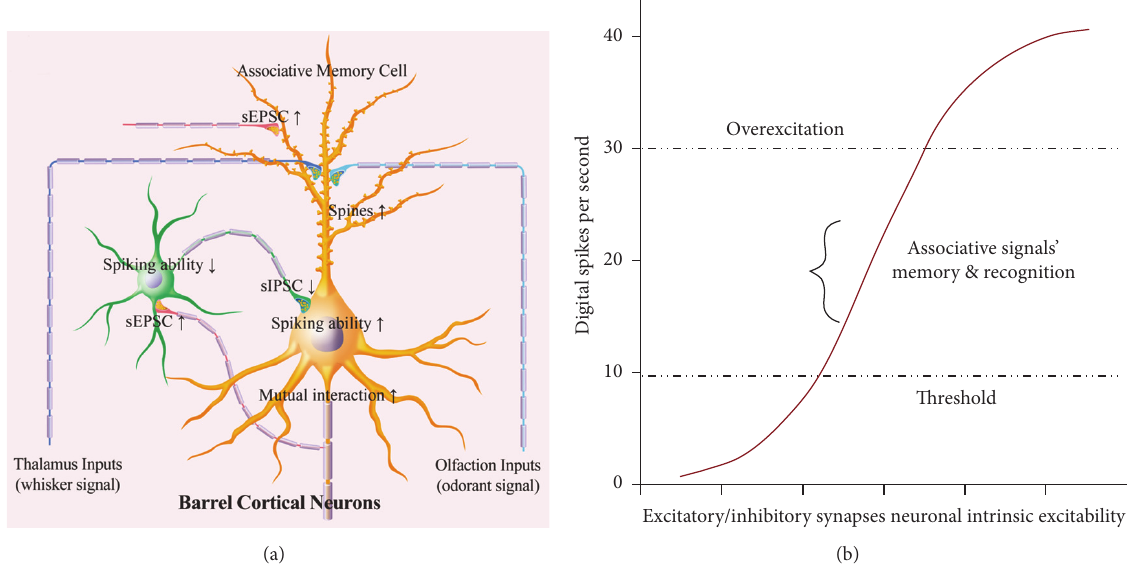
Figure 10: The coordinated recruitment and refinement of barrel cortical glutamatergic and GABAergic neurons set up their function state for information storage. (a) In addition to receiving whisker signal from the thalamus, associative memory cells in the barrel cortex receive odor signal from the piriform cortex after associative learning. In the glutamatergic neurons (orange), their dendritic spines are enriched, their excitatory synaptic transmissions are upregulated, and their receiving of inhibitory synaptic transmission is downregulated for their recruitments to be associative memory cells. The innervations from GABAergic axons are increased, such that the glutamatergic neurons are not overexcited. In the GABAergic neurons (green), their processes are enriched, their receptive fields of excitatory synaptic transmission are enhanced, and their innervation from the excitatory neurons is increased. Their synaptic outputs are decreased. The GABAergic neurons are homeostasis by coordinating their subcellular compartments. (b) An upregulation in the ratio of the excitatory synapses to the inhibitory synapses drives the digital spike encoding at theexcitatory neurons over the threshold (out of “functional silence”) into an optimal state for the recruitment and refinement of associative memory cells. The extreme weakness of inhibitory synapses pushes these neurons to be overexcited for strong memory with no recognition. The curve of digital spikes is simulated based on our data, in which the normalized stimulations are integrated by the ratio of excitatory synapses to inhibitory